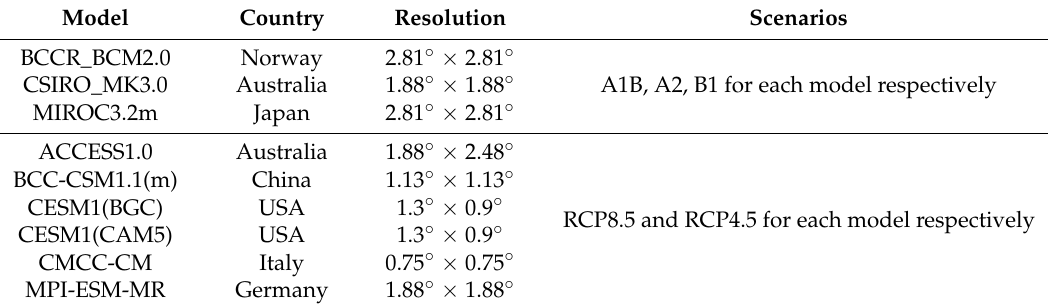
Table 1. Details of CMIP3 and CMIP5 climate models and scenarios used in this